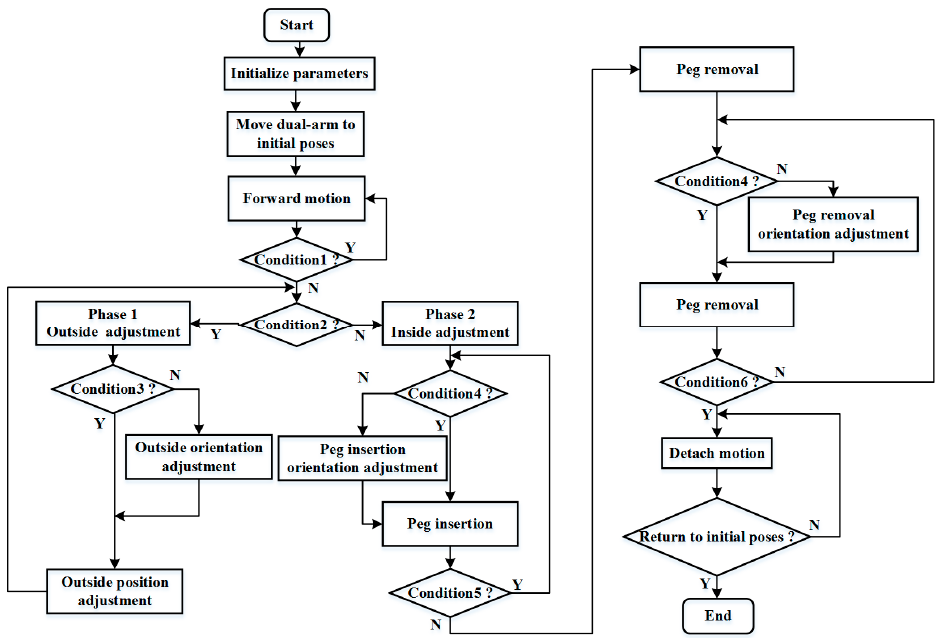
Figure 6. Control flow during the whole assembly process (Condition1: abs(Fz) < thresd_a;